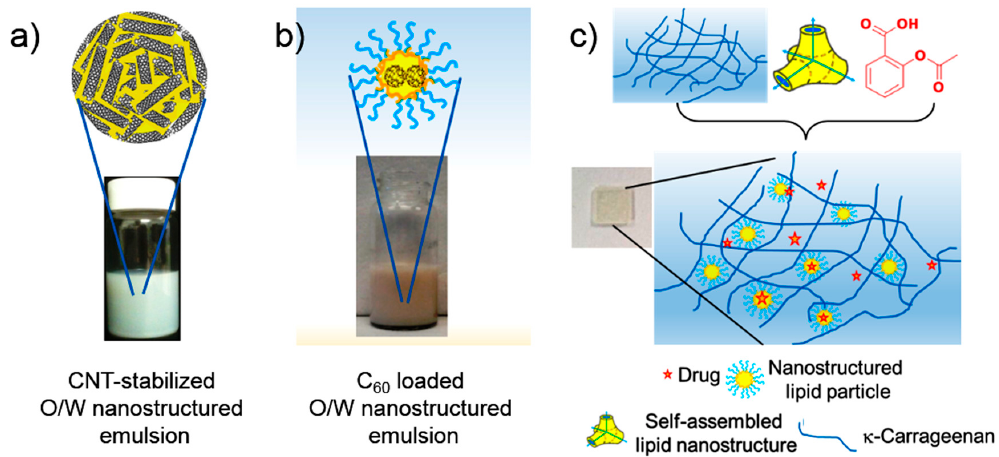
Figure 8. Lipid-based nano-hybrid systems prepared using ( a ) carbon nanotubes (CNTs), ( b ) fullerene (C 60 ) and ( c ) κ -carrageenan (KC) as a hydrogelator (and a drug, aspirin).